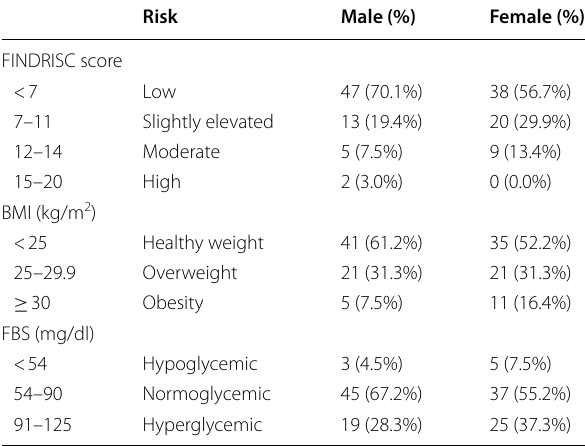
Table 3 Distribution of FINDRISC, BMI and fasting blood sugar level across